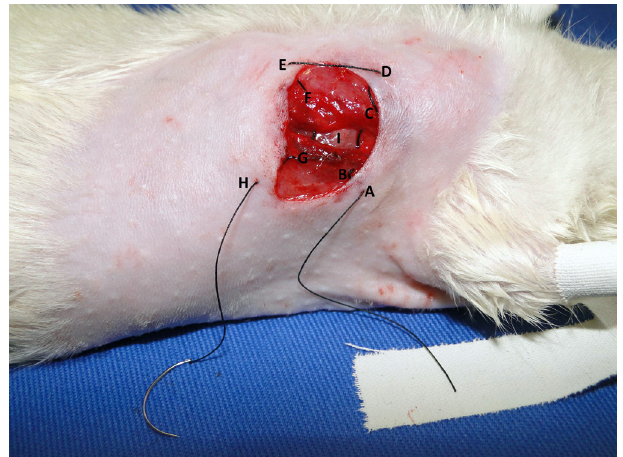
Fig. 2 - The route of the continuous cotton thread that is placed around the surgical incision before opening the chest in the G2